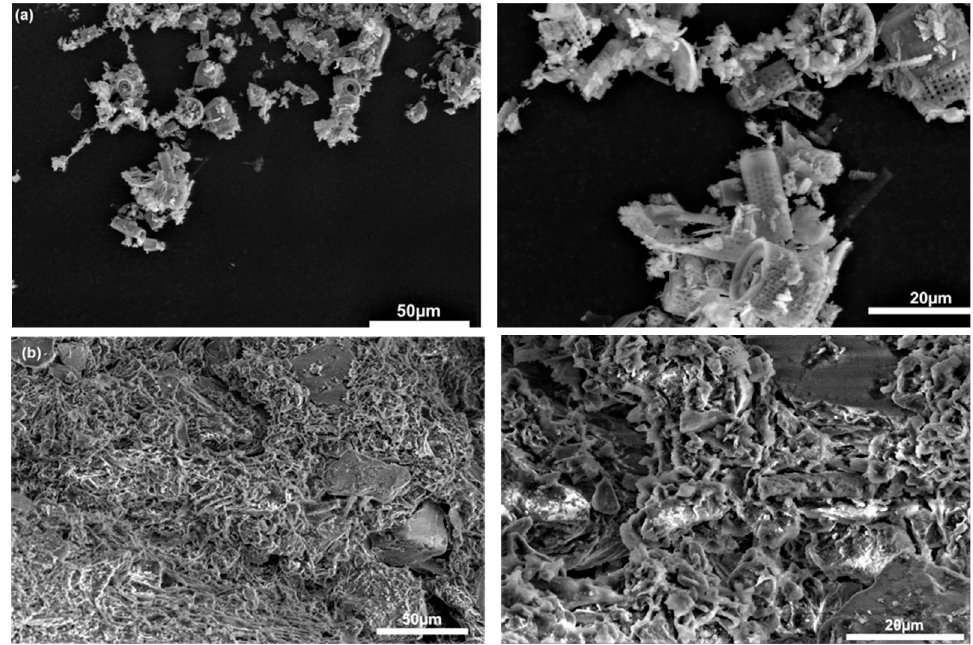
Figure 1. SEM images of ( a ) diatomaceous earth ( b ) peat at different magnifications: 50 and 20 µm diameter particles.